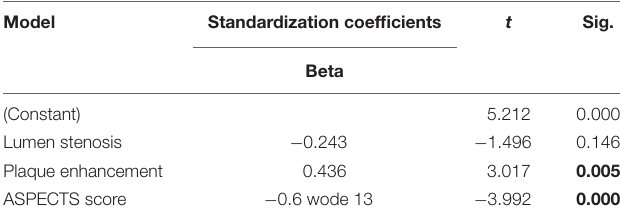
TABLE 3 | Associations between imaging parameters and inter-hemispheric DWMH volume difference.